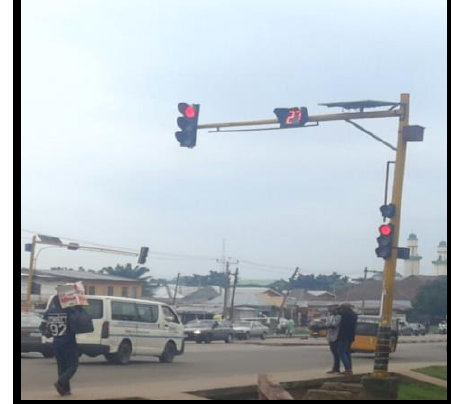
Figure 3. Red Light Running, NSTA